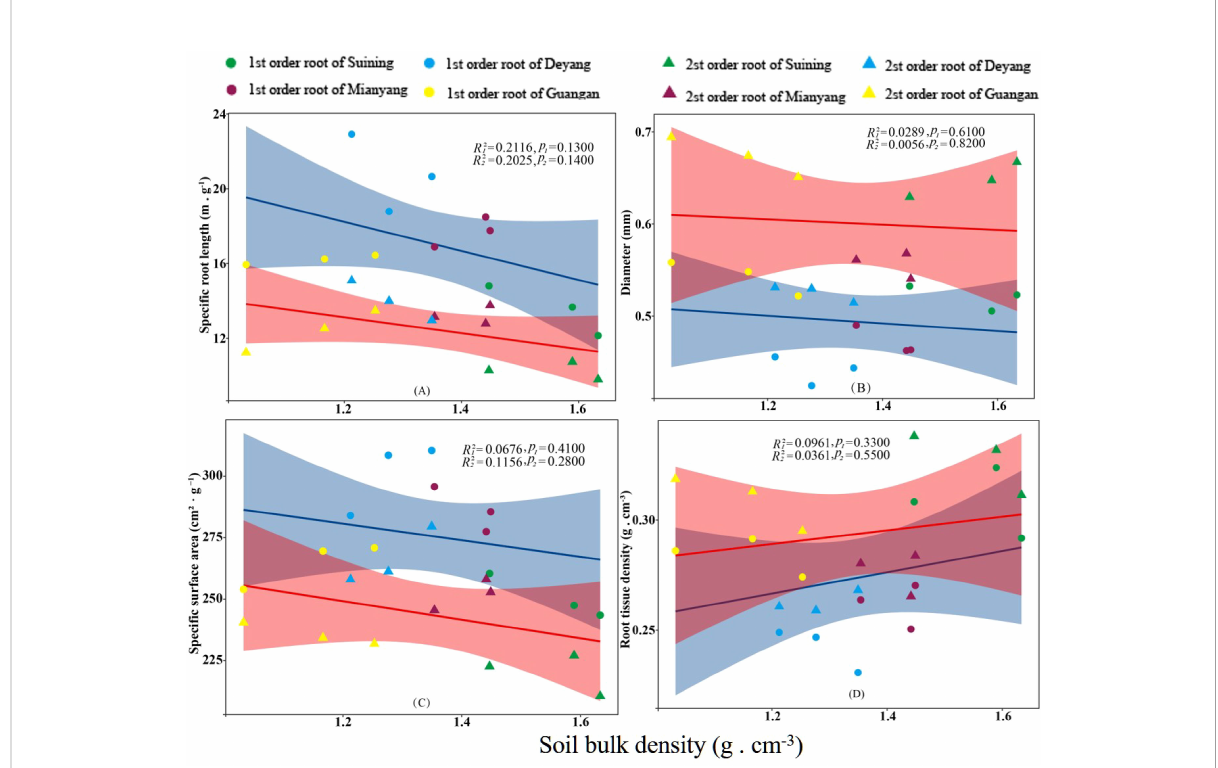
FIGURE 8 Effects of soil bulk density on speci fi c root length, root diameter, speci fi c root surface area, and root tissue density at four research sites. R 1 2 and R 2 2 represent coef fi cients of determination for regressions of fi rst- and second-order fi ne roots * and ** indicate signi fi cance at p < 0.05 and p < 0.01, respectively. p 1 and p 2 are p-values indicating signi fi cance of regressions with fi rst- and second-order fi ne roots, respectively. The shaded part is the con fi dence interval of the fi tting line, regimes (n = 3 per